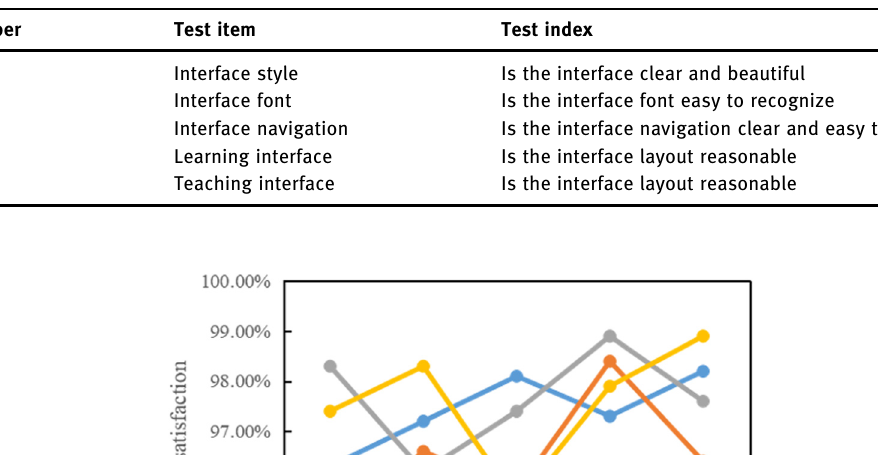
Table 3: Interface test item description table